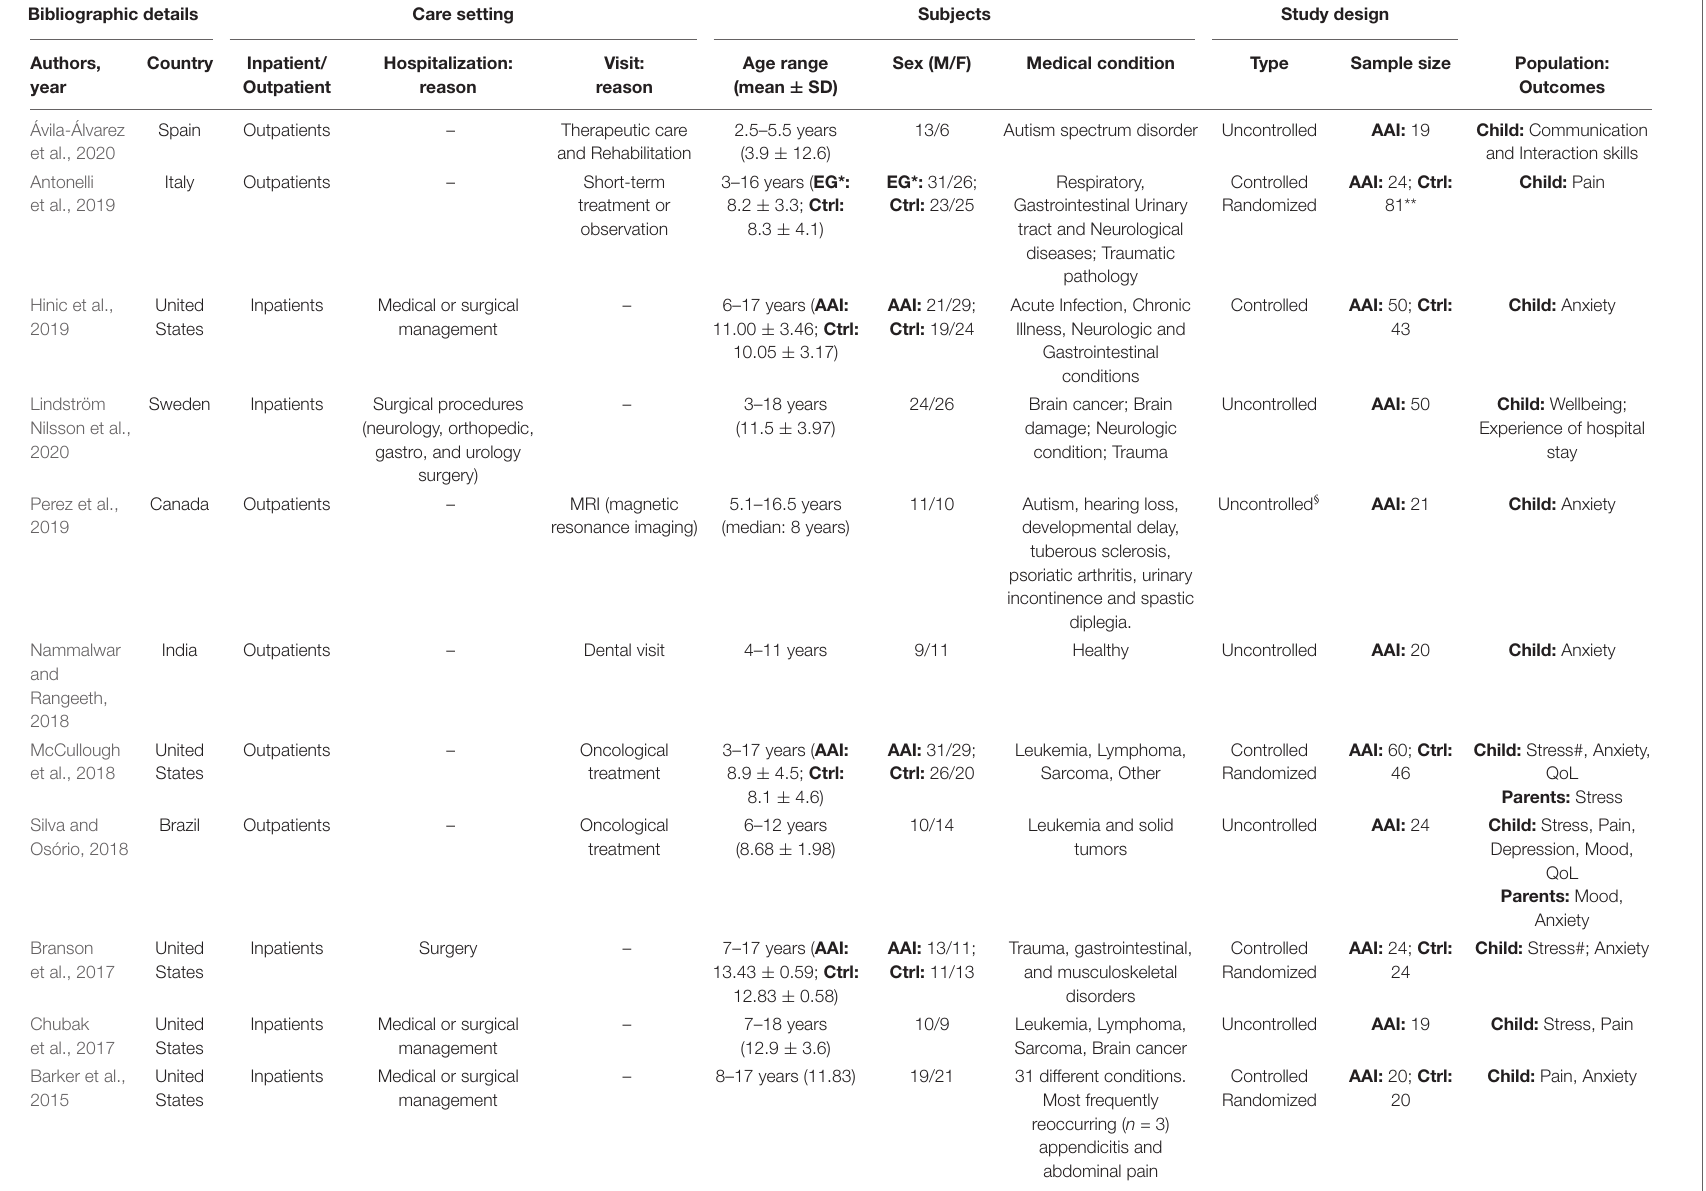
TABLE 1 | Characteristics of the included